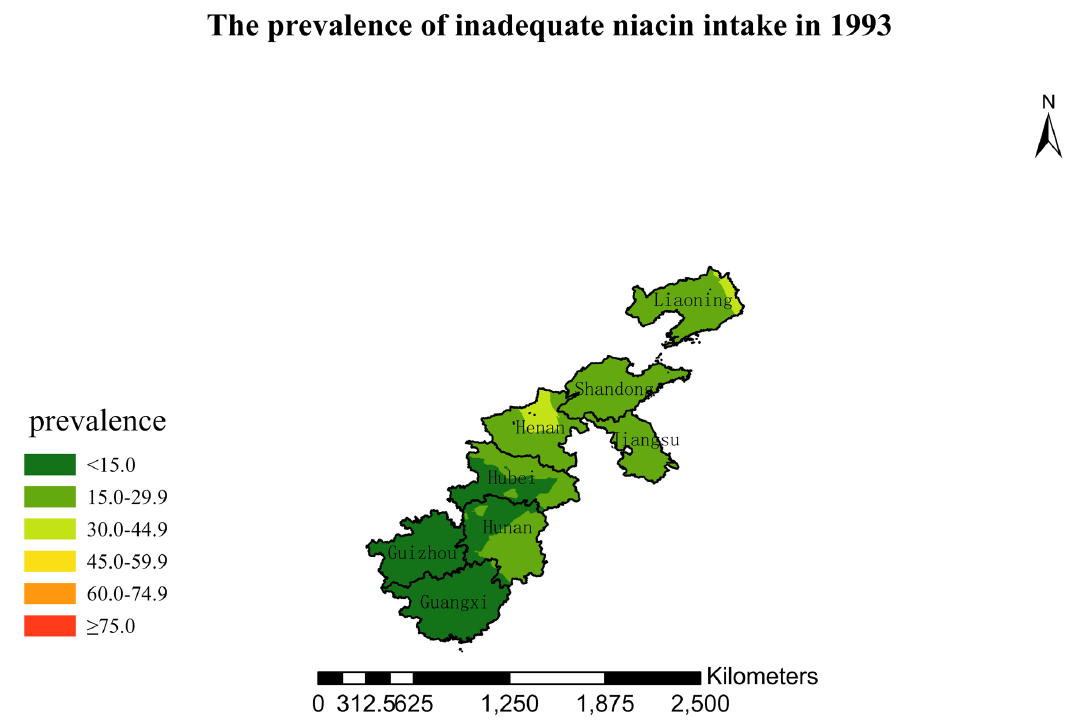
Figure 2. The prevalence of inadequate niacin intake by county in 1993 among Chinese Residents ≥ 5 Years of Age.